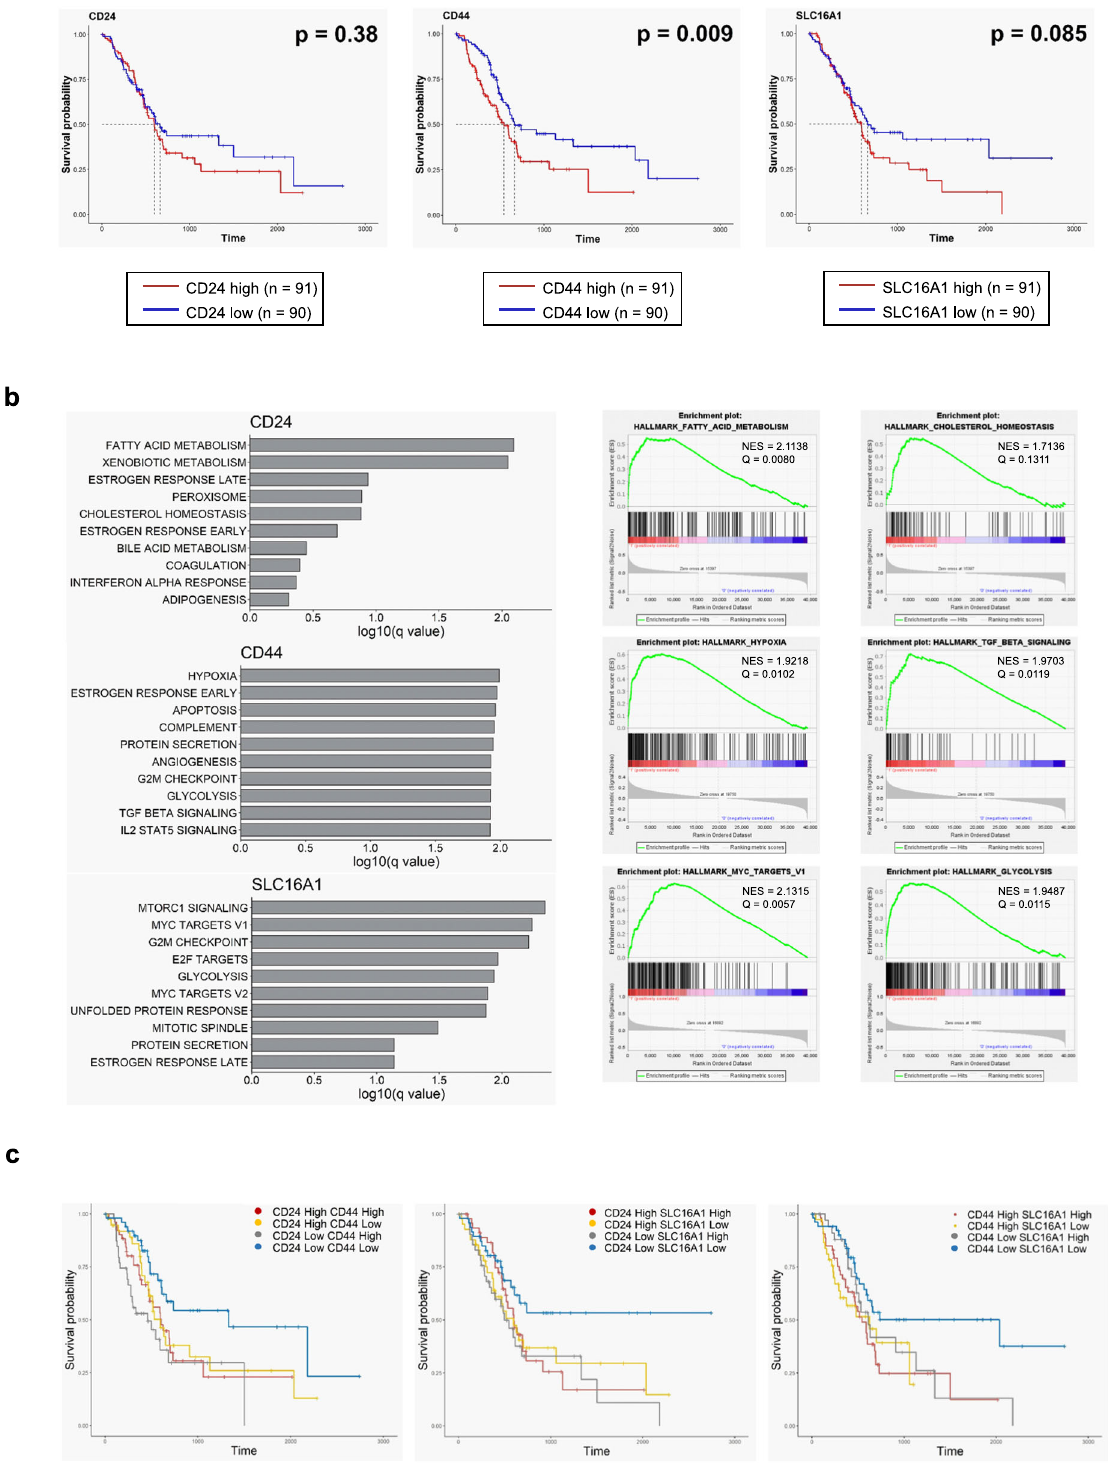
potentials in terms of tumorigenicity and metastasis (Fig. 2 and Supplementary Fig. 3c, d) and genomic structural variants (SVs) including a novel BCL2L1-GLB1L2 fusion gene (Supplementary Fig. 2c, d). These fi ndings suggest that direct cell-to-cell transfer may represent a mean through which intratumoral heterogeneity